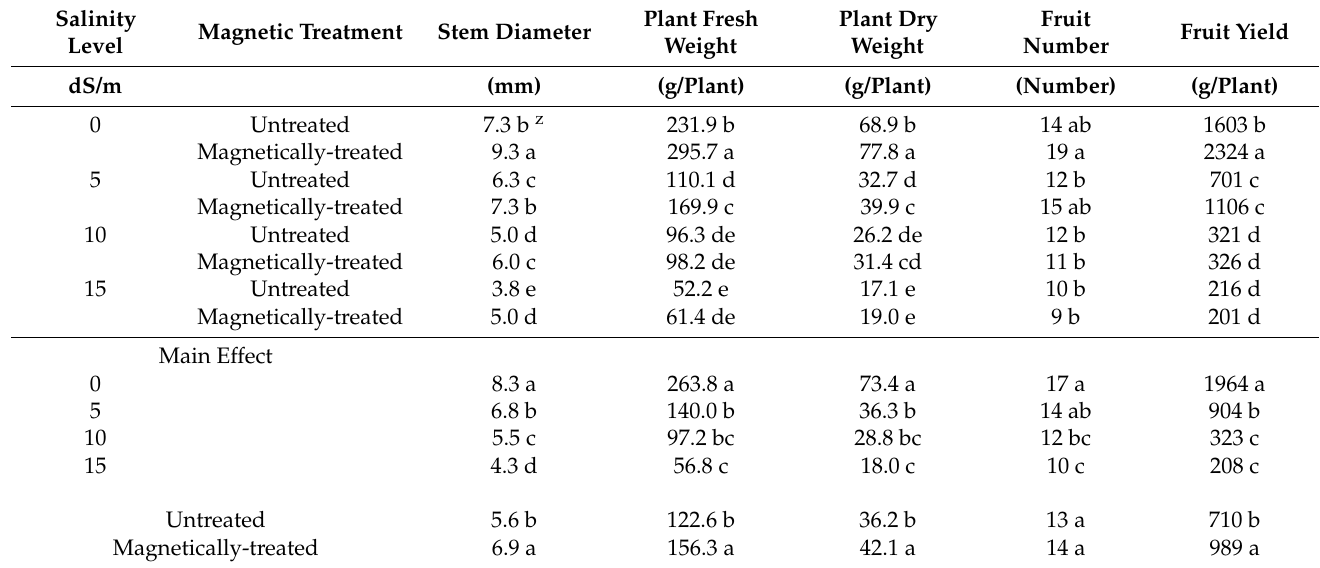
Magnetically-treated 6.9